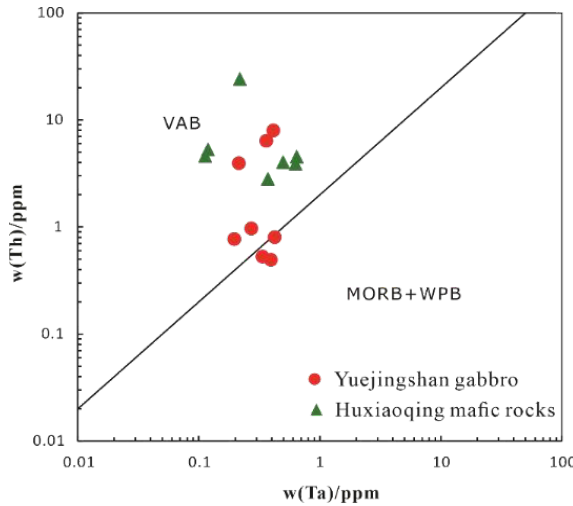
Figure 12. Th vs. Ta diagram for Yuejingshan gabbro samples. Data for Huxiaoqing mafic rocks originate from Liu, Ma [10].